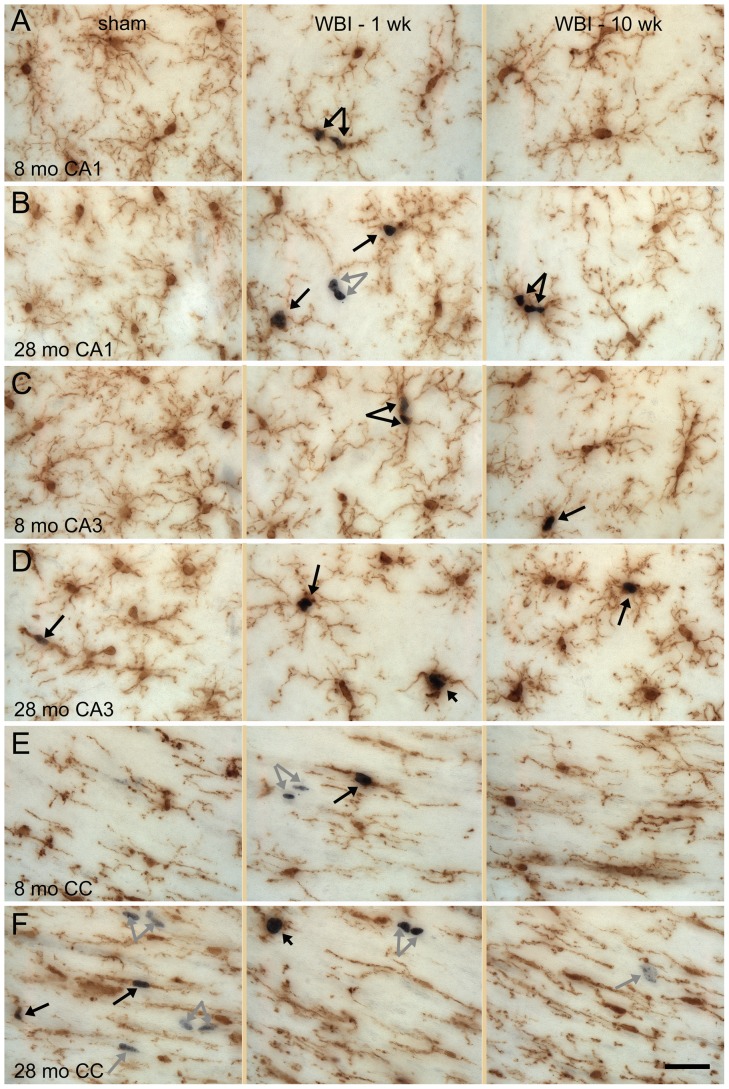
Microglial morphology.Immunolabeling for Iba1 (brown) demonstrates microglia in CA1 (A, B), CA3 (C, D) and CC (E, F). The appearance of microglia in sham controls and at 1 and 10 weeks after WBI is illustrated for young adult (8 mo) and old (28 mo) rats. Double-labeling for Iba1 and Ki67 (black) demonstrated proliferation of microglia (black arrows) and of non-microglial cells (gray arrows). Most proliferating microglia had extensive processes (long arrows) but a few (short arrows in D and F WBI-1 wk) exhibited larger cell bodies and only a few short processes. Scale bar = 25 µm. Images shown are z projections of five image planes representing 10 µm section depth.